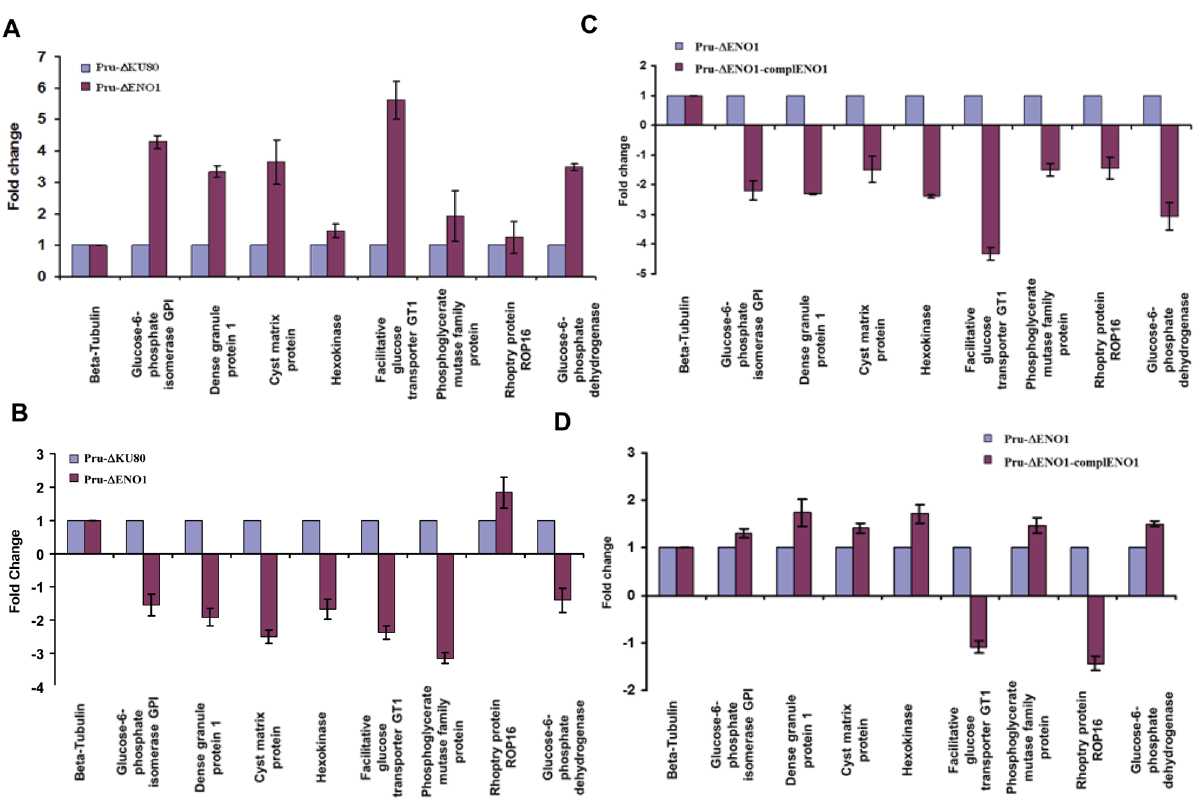
Figure 9. Targeted deletion of TgENO1 and complementation of the knockout demonstrate that nuclear enolase modulates gene transcript levels. A) Total RNA extracted from intracellular tachyzoites of Pru D ku80 D Tgeno1 mutants or parental Pru D ku80 grown in normal culture conditions was reverse transcribed and used for quantitative RT-PCR. The eight enolase target genes selected by ChIP-Seq and beta tubulin, a housekeeping gene, were analyzed. B) Total RNA was extracted from intracellular tachyzoites of the Pru D ku80 D Tgeno1 mutant or parental Pru D ku80 after bradyzoite interconversion in vitro using alkaline (pH 8) stress culture conditions. After reverse transcription, the cDNA was subjected to quantitative RT-PCR analysis of the eight enolase target genes selected by ChIP-Seq and beta tubulin. C) Total RNA extracted from intracellular tachyzoites of Pru D ku80 D Tgeno1 mutants complemented with TgENO1 plasmid or parental Pru D ku80 parasites grown in normal culture conditions was reverse transcribed and used for quantitative RT-PCR analysis of the eight enolase target genes and beta tubulin. D) Total RNA was extracted from intracellular tachyzoites from Pru D ku80 D Tgeno1 mutant complemented with TgENO1 plasmid or parental Pru D ku80 parasites after bradyzoite interconversion in vitro using alkaline (pH 8) stress culture conditions. After reverse transcription, the cDNA was subjected to quantitative RT-PCR analysis of the eight enolase target genes selected by ChIP-Seq and beta tubulin. These experiments were performed at least three times with identical results (n=3, P , 0.0001).